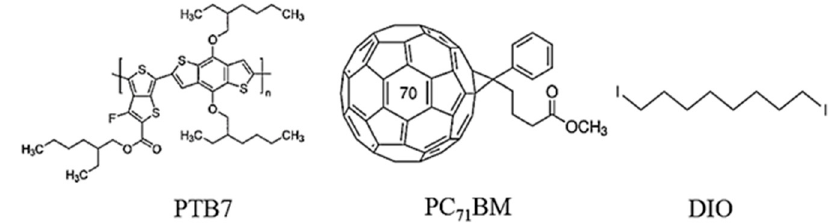
Figure 1. Chemical structures of PTB7, PC 71 BM and DIO.